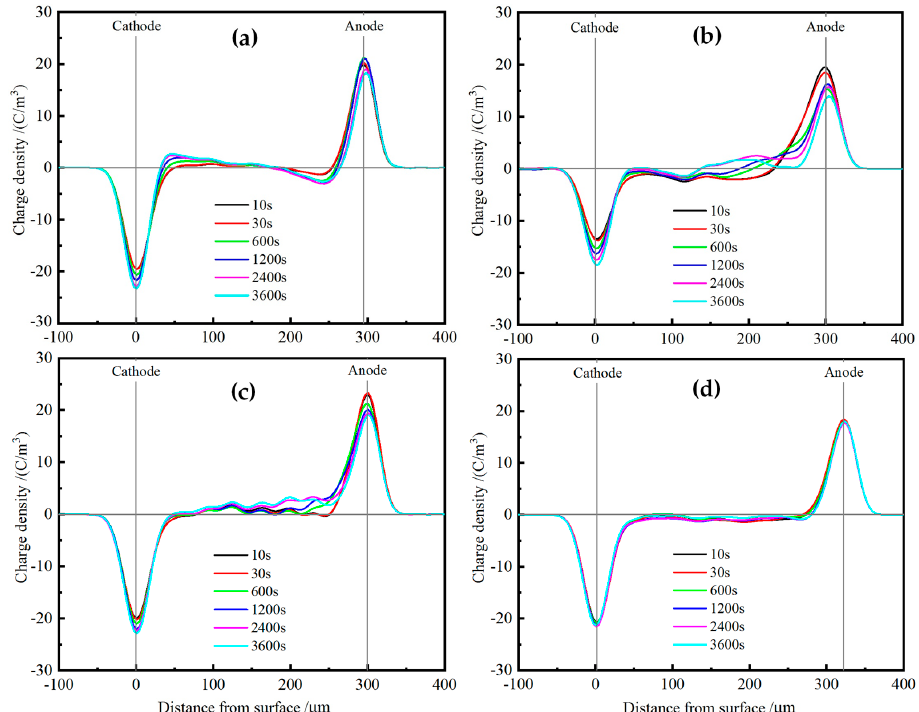
Figure 8. Space charge distributions in ( a ) pure XLPE and the nanocomposites of ( b ) 0.5wt%TAIC- s -SiO 2 /XLPE, ( c ) 1.5 wt% TAIC- s -SiO 2 /XLPE and ( d ) 2.0 wt% TAIC- s -SiO 2 /XLPE under DC electric field of 40 kV/mm at 25 °C.